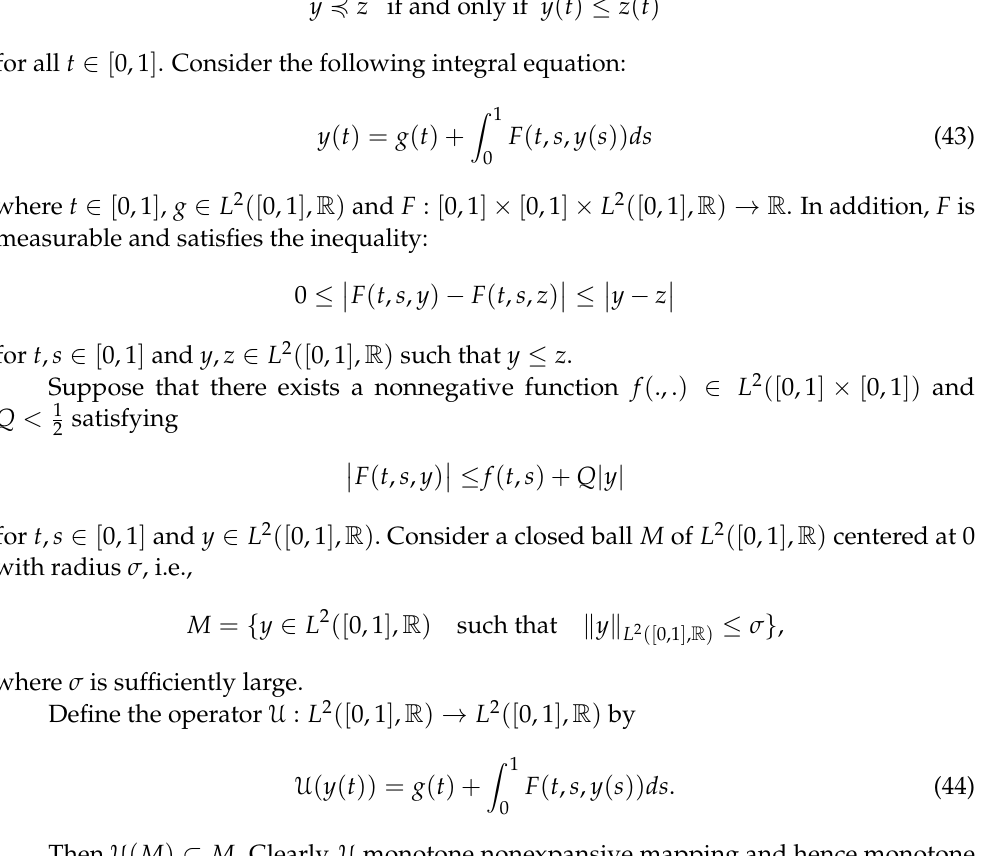
Figure 2. Comparison of Iteration Processes for different choices of parameters: α n = 1 β n = 1 √ (right 2 n + 5